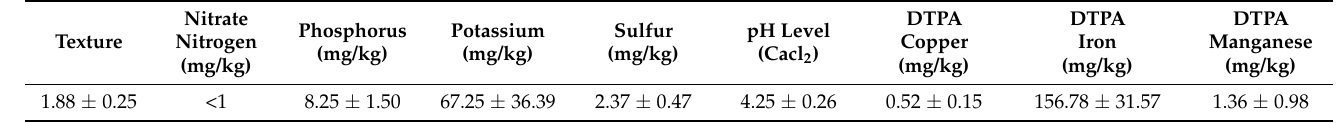
Table 5. The physicochemical properties of topsoil to 200 mm depth, which represents the distribution of the majority of the root profile of K. ambigua in the field